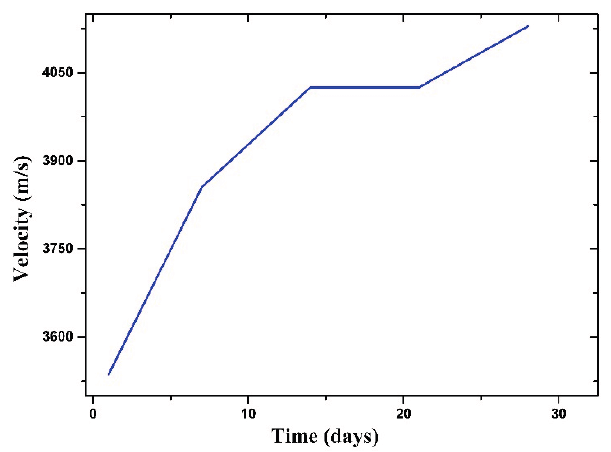
Figure 4. Monitoring the mortar cylinder curing process through the measurement of ultrasonic velocity over